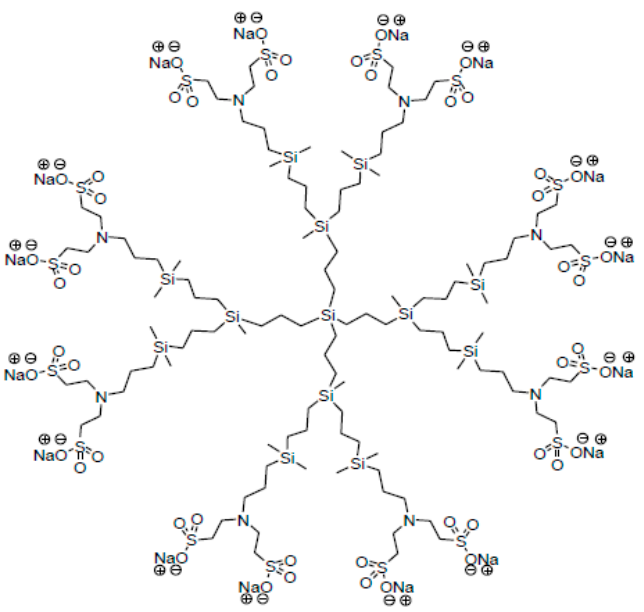
Figure 2. Schematic representation of the G2-S16 anionic carbosilane dendrimer.